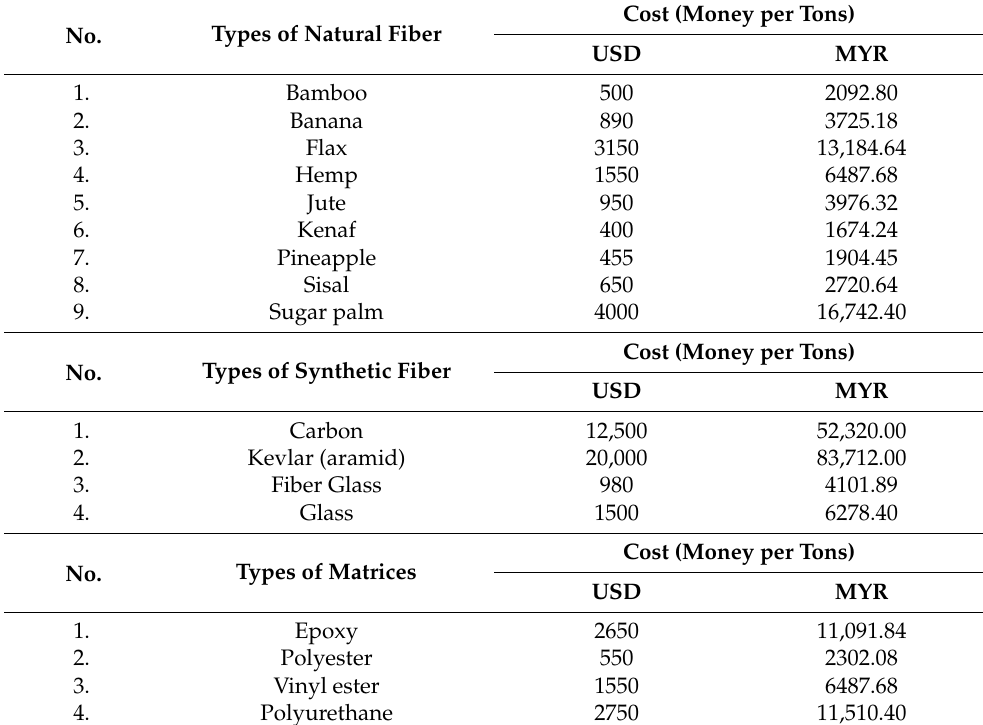
Table 5. Estimated cost of natural, synthetic fiber and matrices in US Dollar (USD) and Malaysia Ringgit (MYR). Extracted from Ref. [292] with